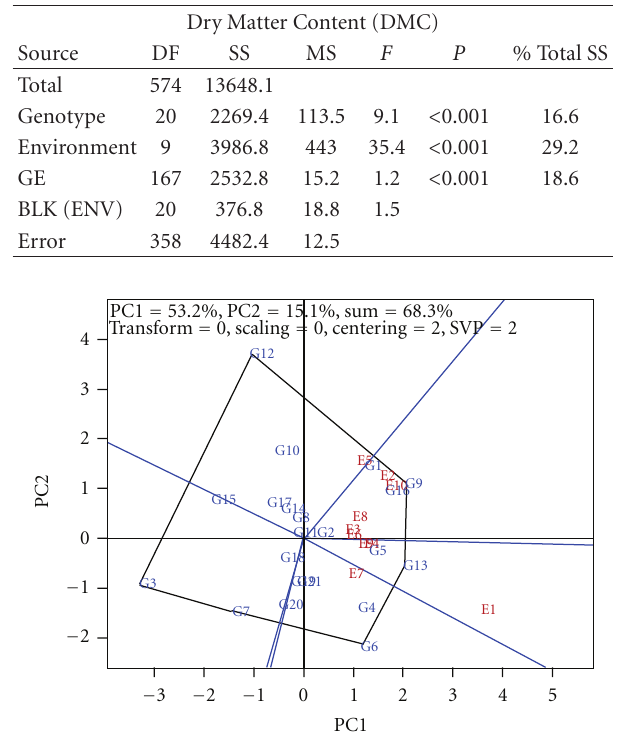
Table 4: Combined analysis of variance table of genotype, environ- ment, and genotype by environment contributions to the sum of squares of dry matter content of 21 yellow-fleshed genotypes in 10 environments.